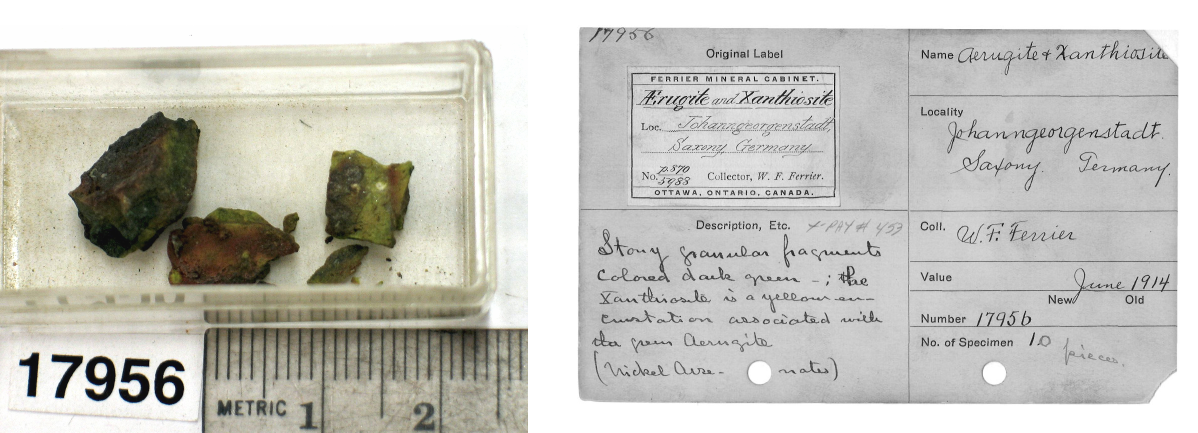
Figure 2. Old catalogue card with original Ferrier collection label for the AMNH holotype specimen of